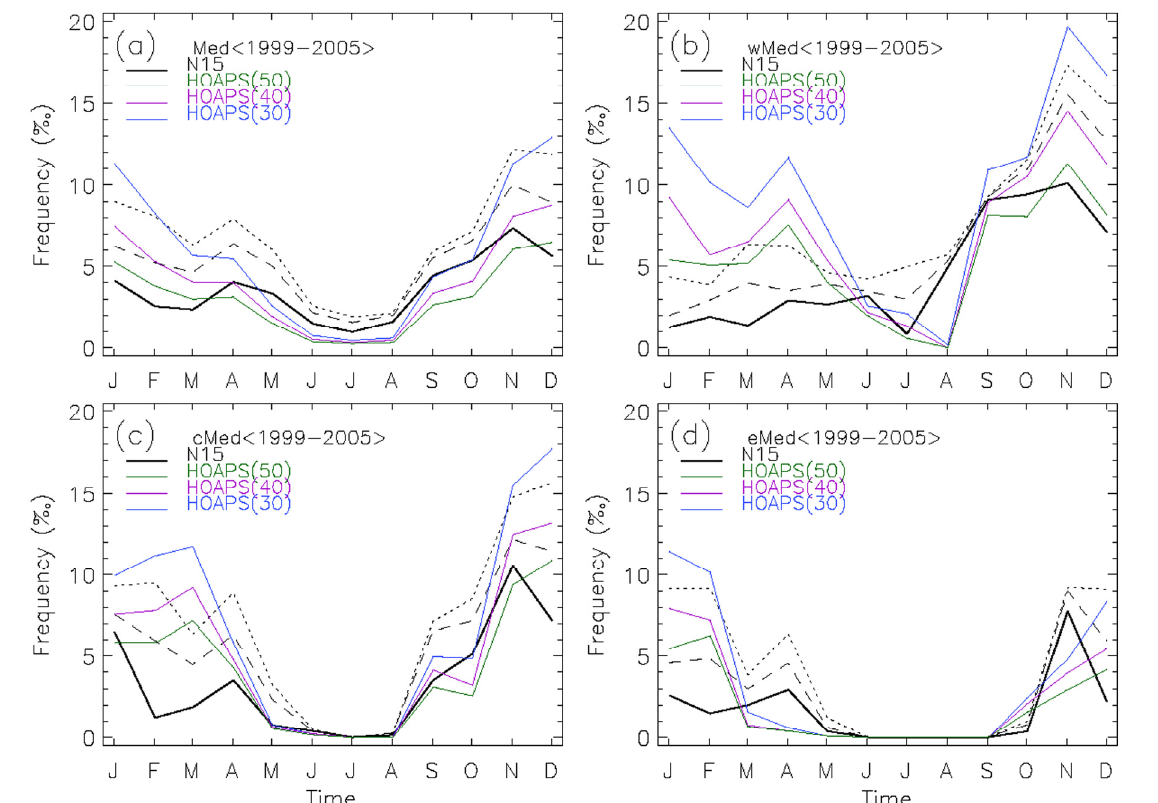
Figure 9. Monthly mean annual cycle averaged over the period 1999–2005 of NOAA-15 MR frequency for different thresholds of UTH (<70%, <50%, and <30%; thick-solid, dashed and dotted black, respectively), and HOAPS-3.2 rain frequency (thin-solid) for different thresholds (30, 40 and 50 mm/day; blue, purple, and green, respectively) in ( a ) Mediterranean Sea (Med), ( b ) wMed, ( c ) cMed and ( d ) eMed (see Figure 8 for the regions